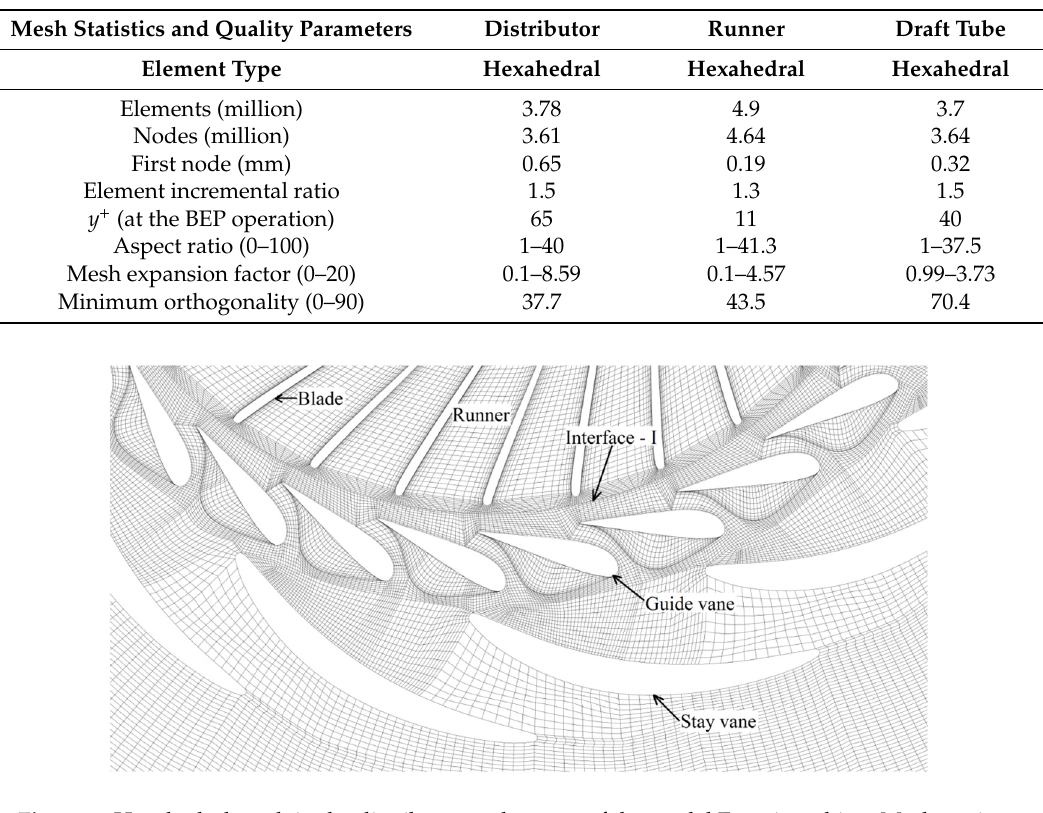
Figure 5. Hexahedral mesh in the distributor and runner of the model Francis turbine. Mesh cut is at the distributor floor.